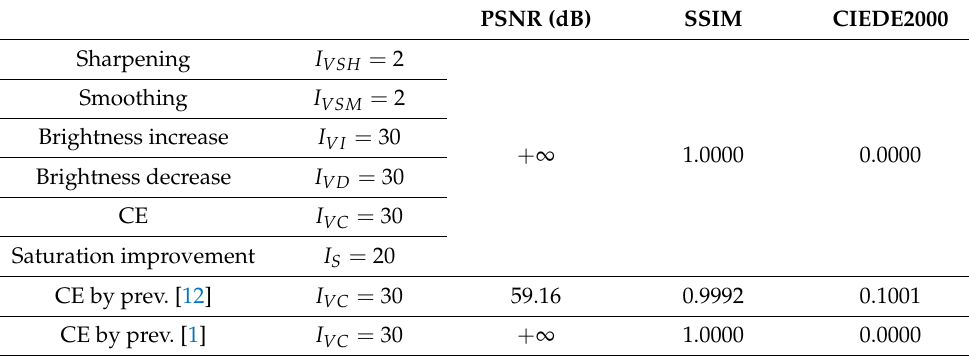
Table 3. Quality of restored